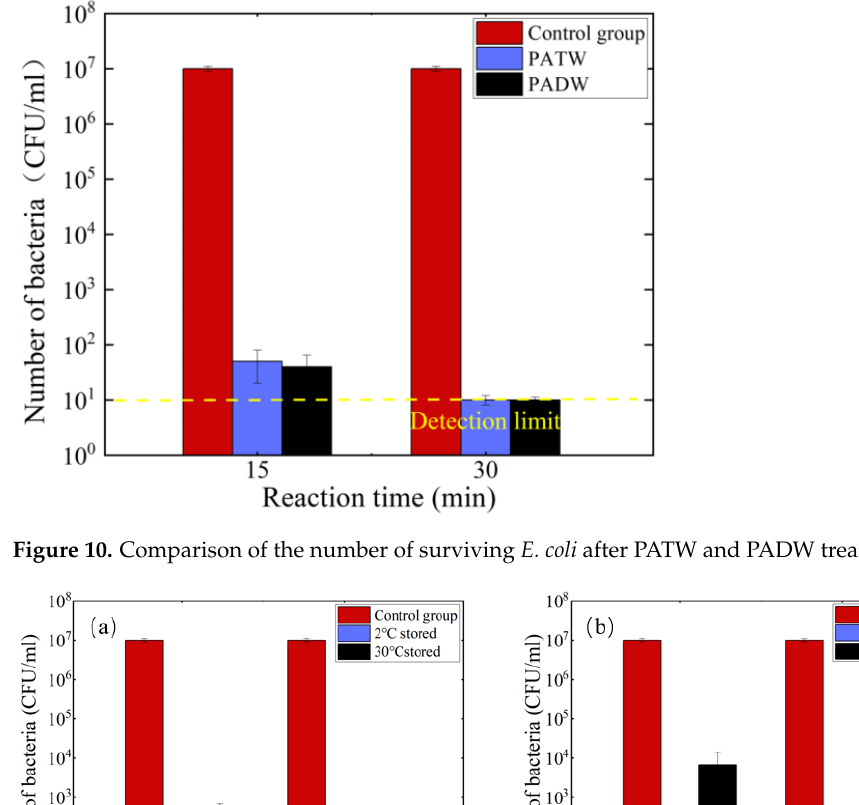
Figure 10. Comparison of the number of surviving E. coli after PATW and PADW treatment.